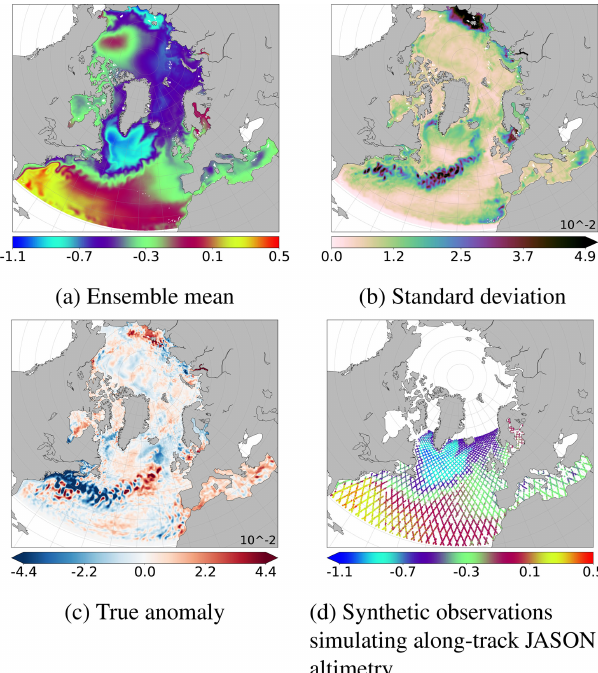
Figure 1. SSH (in metres). Ensemble mean (a) and standard de- viation (b) of the prior ensemble ( N = 69 members). The true anomaly (c) is defined as the difference between the true mem- ber (computed as an additional independent member of the ensem- ble) and the ensemble mean (a) . Synthetic observations simulating along-track Jason altimetry (d) correspond to the true member along the track of the Jason altimeter plus a noise, following Eq. (1).